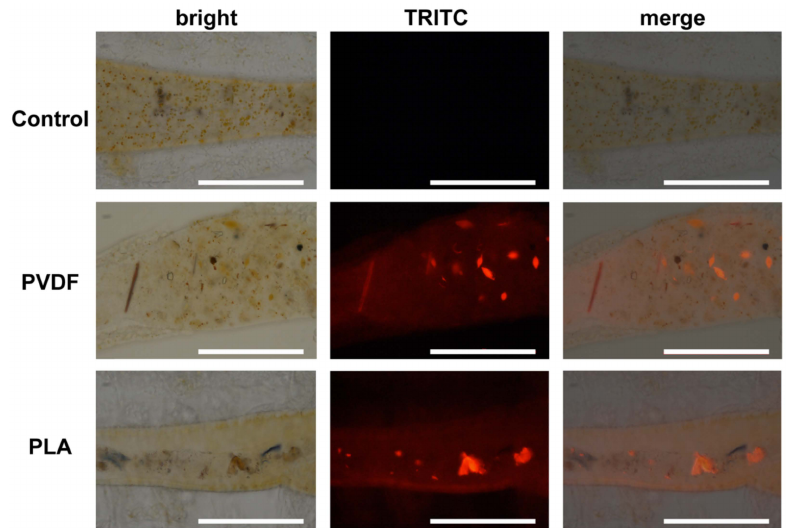
Figure 4. Epifluorescence of PVDF and PLA MPs stained with Nile red in the A. franciscana nauplii. Control refers to A. franciscana nauplii not exposed to MPs. After exposure to PVDF and PLA MPs, materials were localized in the gut. Bars equal 100 µ m.